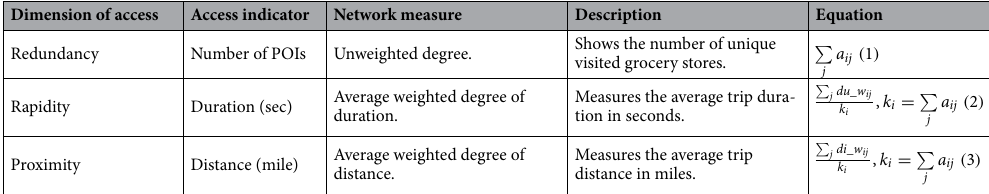
Table 1. Description of the developed access metrics in this study.